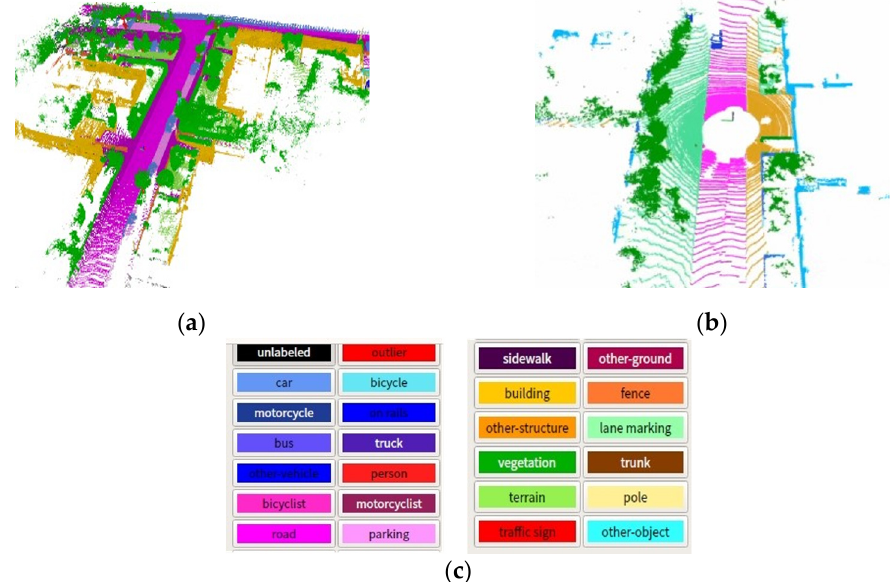
Figure 17. The comparison of point cloud semantic segmentation results: ( a ) segmentation visualization based on the improved RandLa-Net; ( b ) segmentation visualization based on the original RandLa-Net; and ( c ) the label information corresponding to the color. Table 4. Test accuracy on semantickitti 03.